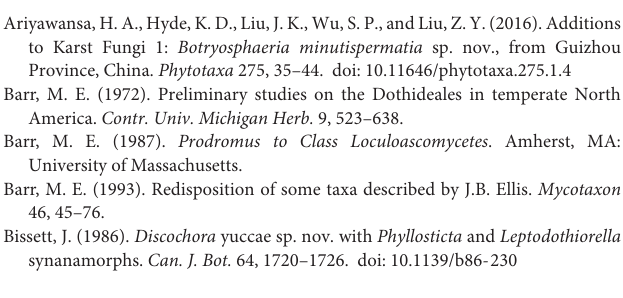
Supplementary Figure 1 | Botryosphaeria gaubae (W 1992-05937, holotype ). (A,B) Ascomata erumpent through the lower side of the leaf. (C) Squash showing cylindrical or broadly cylindrical asci in cotton blue. (D) Part of the peridium. (E) Septate pseudoparaphyses in cotton blue. (F-H) Aseptate, fusiform to ellipsoid ascospores in cotton blue. Scale bars: (A) = 1 mm, (B) = 200 µ m, (C) = 50 µ m, (E) = 20 µ m, (D,F-H) = 10 µ m. Supplementary Figure 2 | Laestadia apocyni (MICH 14281, isotype ). (A) Ascomata erumpent through a piece of twig epidermis. (B) Released, hyaline, 1-septate ascospores. (C) Ascus in water. (D) Line drawing of ascus in water. Scale bars: (A) = 200 µ m, (B-D) = 20 µ m. Supplementary Figure 3 | Sphaeria smilacinina (NYS f2818, holotype ). (A) Ascomata erumpent through the twig epidermis. (B,C) Immature asci. (D) Released ascospores. (E) Line drawing of broadly clavate ascus. Scale bars: (A) = 500 µ m, (B-D) = 20 µ m, (E) = 40 µ m. Supplementary Figure 4 | One of the most parsimonious trees obtained from combined ITS, LSU, tub2, and tef1-a sequence data of Botryosphaeria spp. Outgroup taxa are Neofusicoccum luteum and Neofusicoccum parvum . Maximum parsimony (MP) support values above 70% and Bayesian posterior probabilities (PP) support above 80% are shown with MP bootstrap followed by Bayesian PP (MP/PP) values at the nodes. The species characterized in this study are in boldface. Supplementary Figure 5 | One of the most parsimonious trees obtained based on combined ITS, tef1- α , and tub2 sequence data of Neofusicoccum spp. Outgroup taxon are Botryosphaeria dothidea and B. corticis . Maximum parsimony (MP) support values above 60% and Bayesian posterior probabilities (PP) support above 80% are shown with MP/PP, values at the nodes. The species characterized in this study are in boldface. Supplementary Figure 6 | One of the most parsimonious trees obtained from LSU sequence dataset of Neofusicoccum spp. Outgroup taxa are Botryosphaeria corticis and B . dothidea . Maximum parsimony (MP) support values above 70% and Bayesian posterior probabilities (PP) support above 80% are shown with MP bootstrap followed by Bayesian PP (MP/PP) values at the nodes. The species characterized in this study are in boldface. Supplementary Figure 7 | One of the most parsimonious trees obtained from ITS and LSU sequence dataset of Nothophoma spp. Outgroup taxa is Didymella calidophila . Maximum likelihood (ML) support values above 50%, Maximum parsimony (MP) support values above 50%, and Bayesian posterior probabilities (PP) support above 95% are shown with ML and MP bootstrap followed by Bayesian PP (MP/PP/ML) values at the nodes. The species characterized in this study are in boldface. Supplementary Table 1 | Species, specimens and GenBank accession numbers of sequences used in this study (newly generated sequences are indicated in